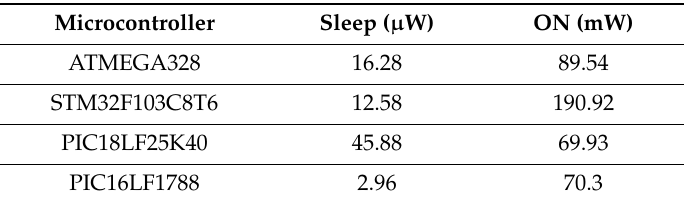
Table 2. Microcontrollers’ power consumption.